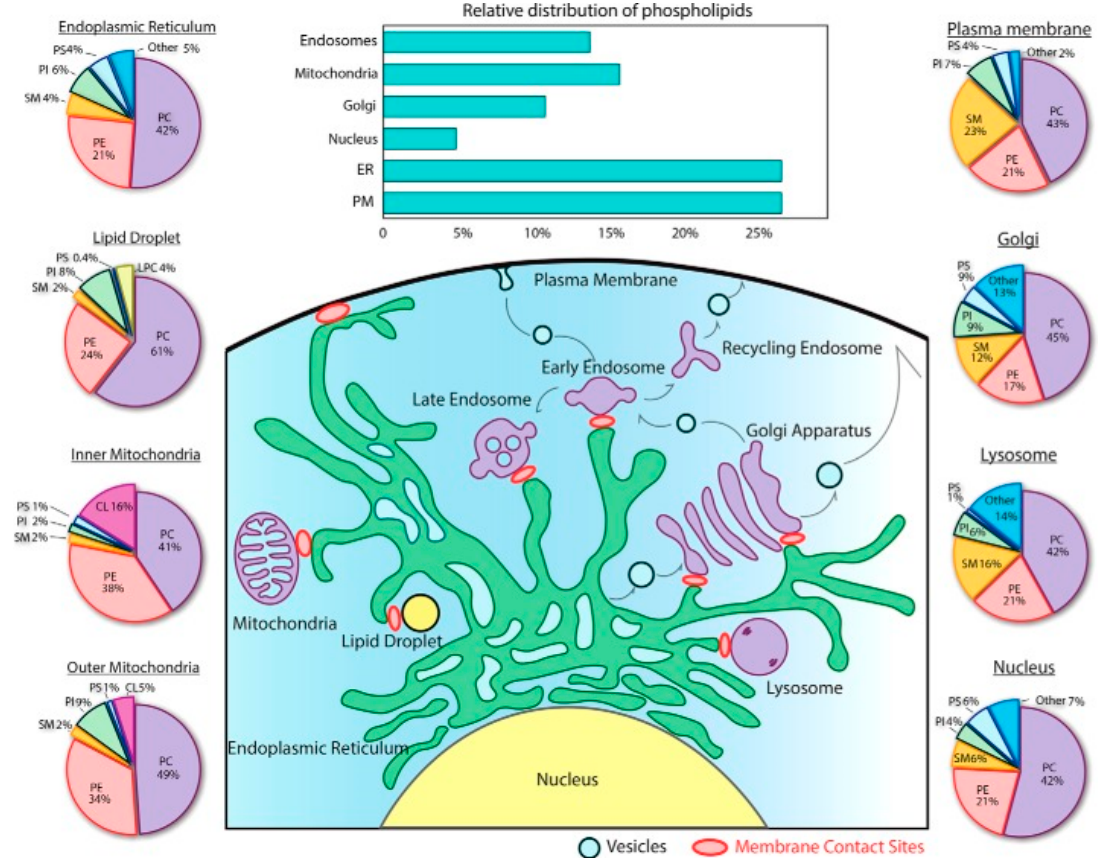
Figure 1. Glycerophospholipid composition of organelles. The bar graph highlights the subcellular distribution of glycer- ophospholipids between the different organelles in baby hamster kidney cells. The pie charts display the relative abun- dance of each lipid class in organelles, based on composite data from rat hepatocytes and (for lipid droplets) from murine hepatocytes. The figure shows the variability of lipids, with phosphatidylcholines (PCs) and phosphatidylethanolamines (PEs) as the most predominant species. Adapted from Yang , et al. [14].